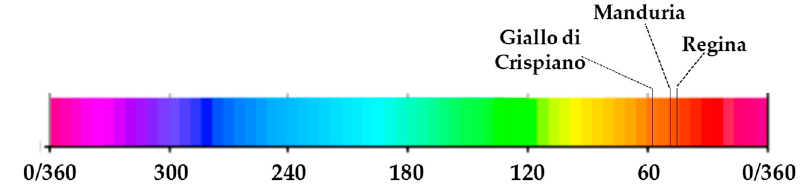
Figure 5. Graphical representation of hue angle (CIE Lab ) detected for the three tomato landraces.